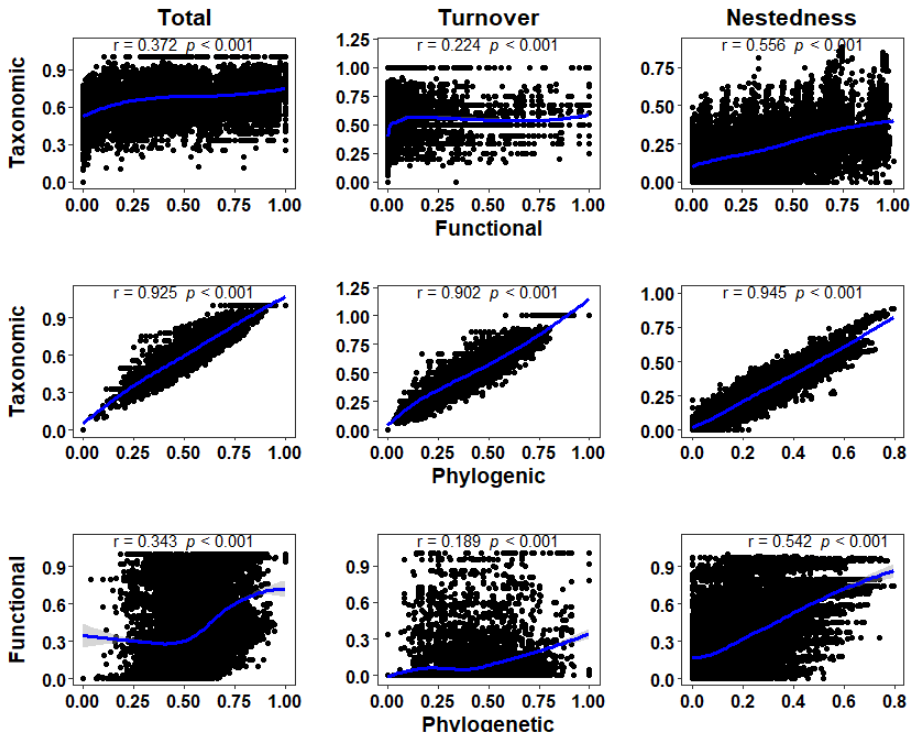
The strongest relationship between taxonomic and functional β -diversity components was found with the Mantel test ( p < 0.001), with the highest Mantel correlation coefficient of nestedness (r = 0.945), followed by total β -diversity (r = 0.925), and turnover (r = 0.902). The correlation between taxonomic and functional β -diversity components was relatively weak ( p < 0.001), with the highest Mantel correlation coefficient of nestedness (r = 0.556), followed by total β -diversity (r = 0.372), and turnover (r = 0.224). The weakest correlation was found between functional and phylogenetic β -diversity, with the highest Mantel correlation coefficient of nestedness (r = 0.542), followed by total β -diversity (r = 0.343), and turnover (r = 0.189) (Figure 2). This supported H2.